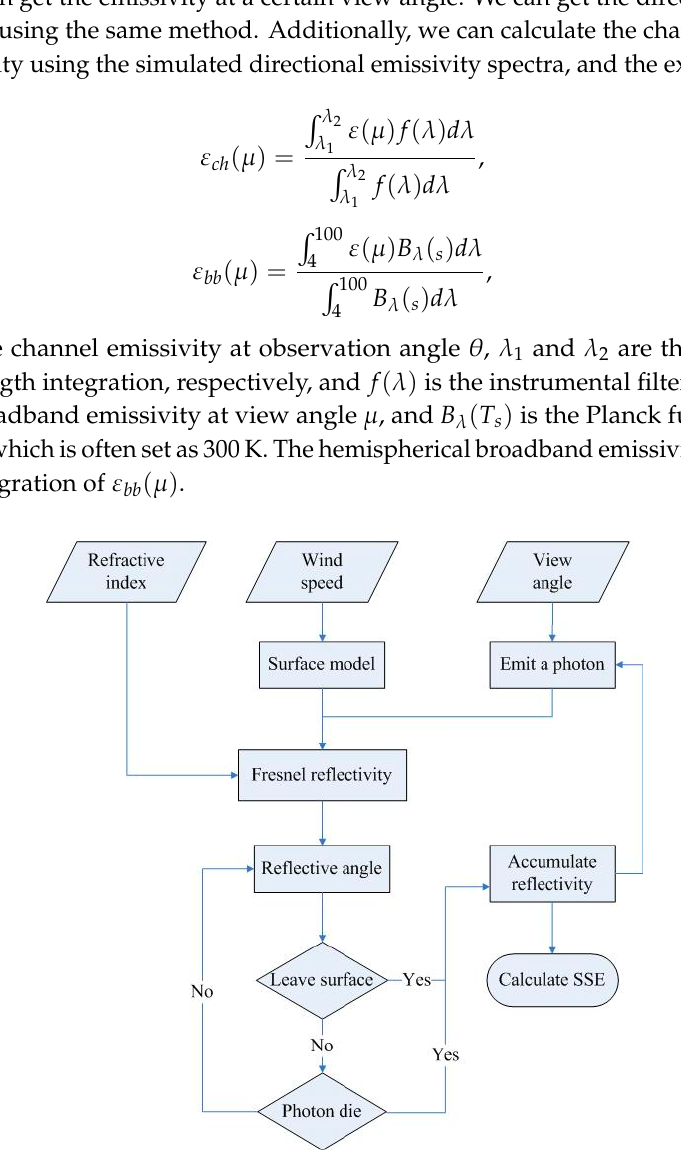
Figure 3. Flowchart describing the procedure for calculating the sea surface emissivity (SSE).